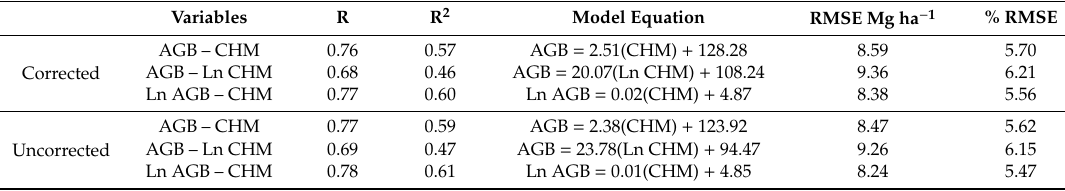
Table 6. Summary of Above-Ground Biomass (AGB) Estimation Models Using Corrected and Uncorrected Shuttle Radar Topography Mission (SRTM) Canopy Height Models